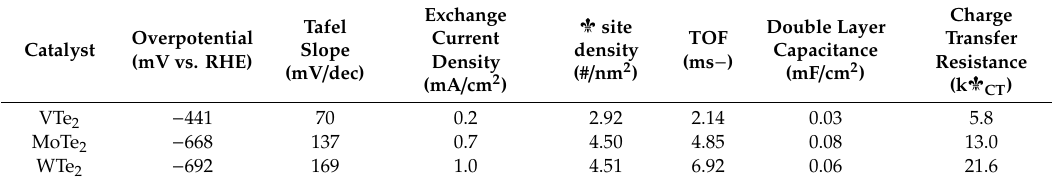
Table 1. Summary of electrochemical properties of three TM Te 2.